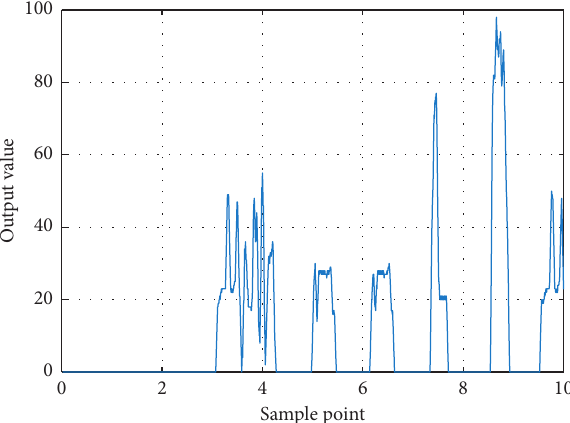
Figure 4: The output of the network node during the